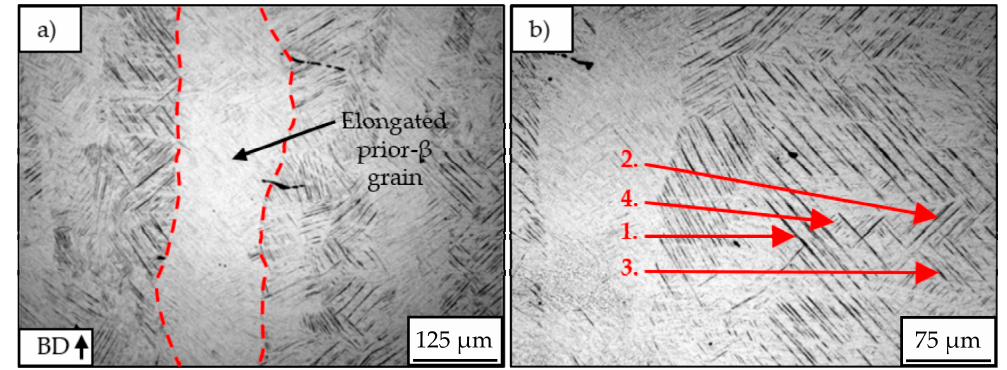
Figure 15. L-PBF typical acicular α ’-martensite structure: ( a ) elongated prior- β grains, ( b ) different martensites (1. primary, 2. secondary, 3. tertiary, 4. quartic).